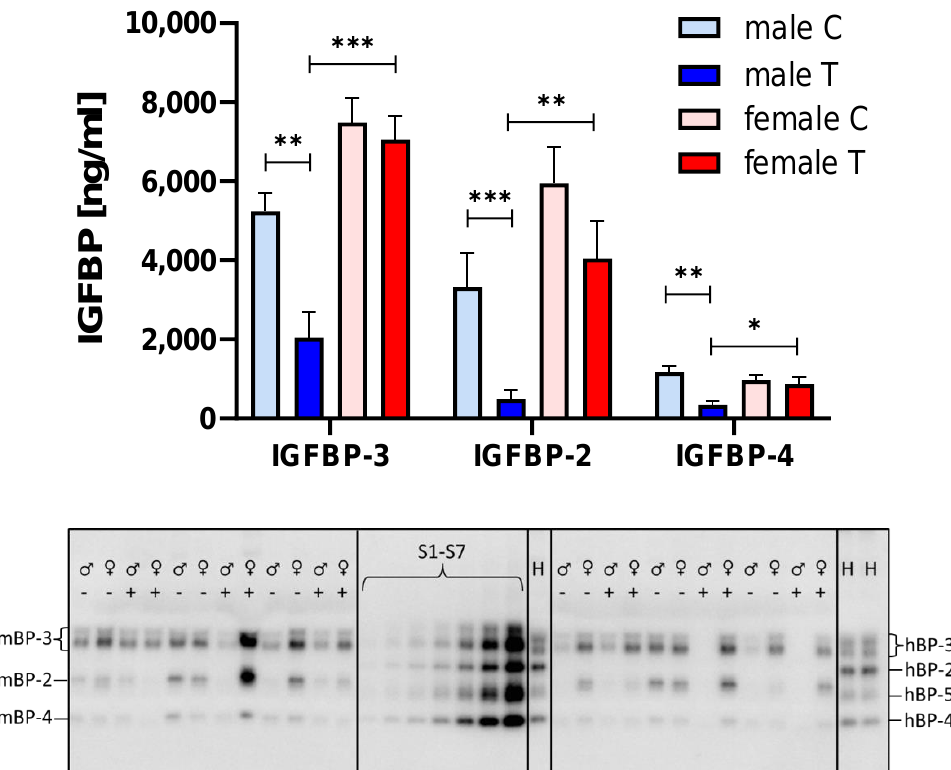
Figure 6 . Concentrations of IGFBPs in serum from male (blue) and female (red) IGFBP-2 transgenic mice (T) and non-transgenic (C) littermates (DU6P/C57BL/6). Analysis was performed by quantitative Western ligand blotting (lower insert) as described in Section 2 (mean ± SEM; age: 7 weeks; n > 10; *: p < 0.05; **: p < 0.01; ***: p < 0.001; H: human control serum containing IGFBP-2 to -5; S1–S7: serial dilutions of human recombinant IGFBP-2 to -5 standards used for the quantification of IGFBPs on each blot).